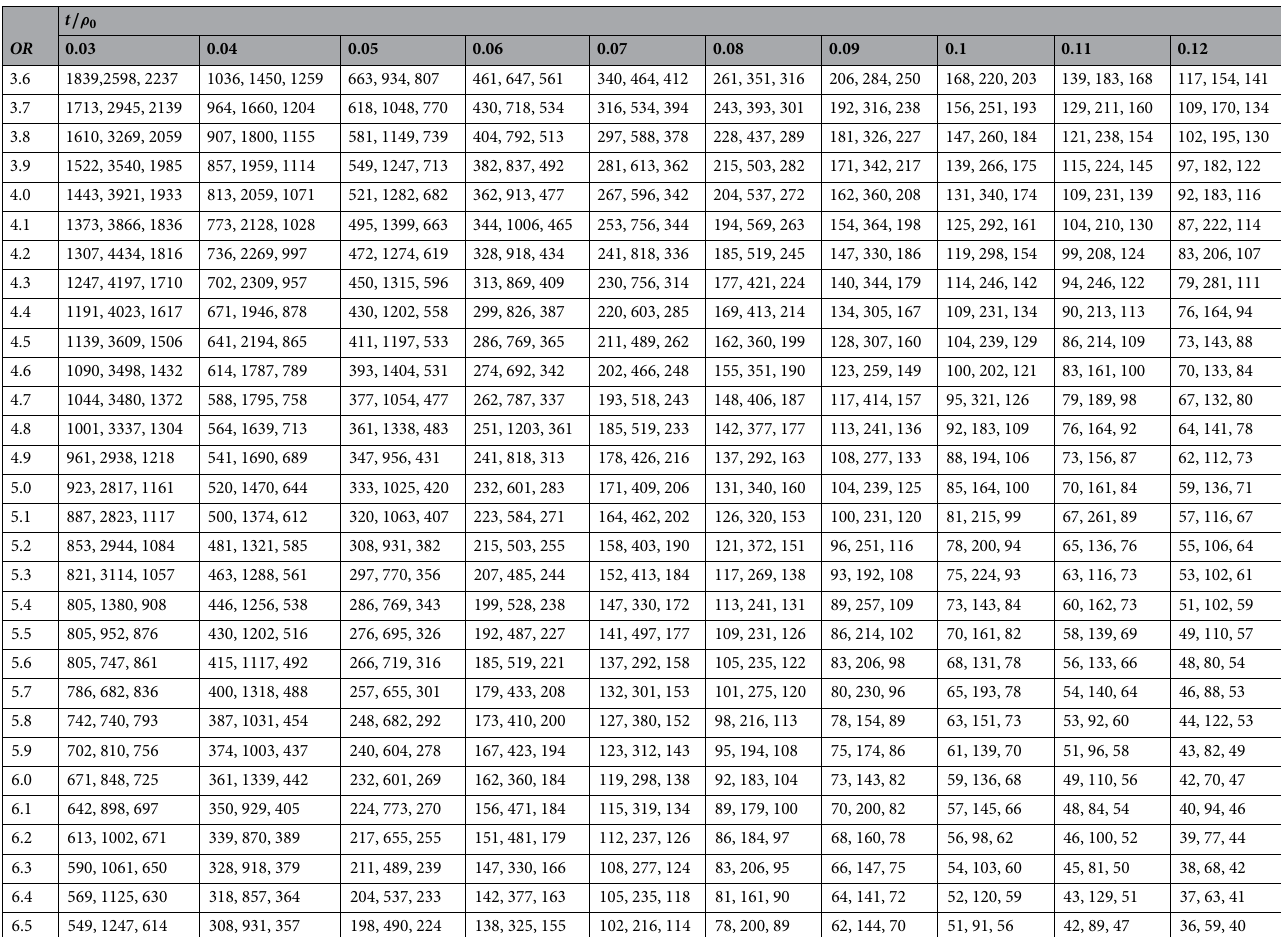
Table 1. Optimum DSP − ( n 1 , n 2 ) for life tests based on Pareto type IV distribution having shape parameters (cid:31) = 1 and η = 0.5 ( r = 0.90). Key: n 1 , n 2 , ASN at p 1